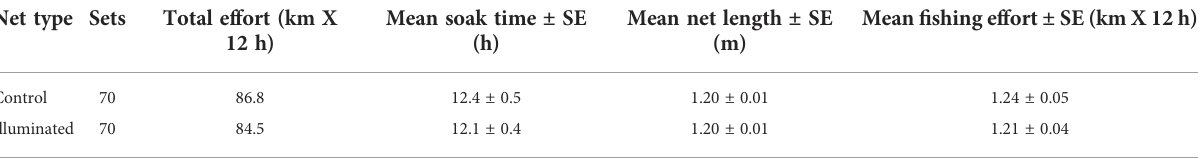
TABLE 1 Summary of fi shing effort by net type (control = nets without LED illumination, Illuminated = nets with LED illumination) for paired gillnets. Net type